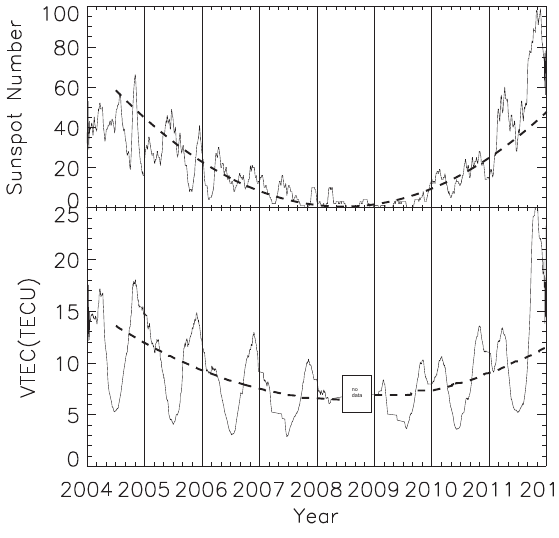
Figure 1. Variation of sunspot numbers (a) and the daily maximum VTEC (b) from 2004 to 2011. Both datasets were 31-day smoothed and fitted using a cubic polynomial regression (dashed curves).